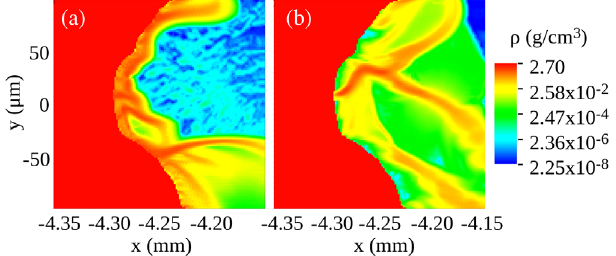
FIG. 8. FLASH 2D-density simulation of a 48-bunch, 200-mA beam dump in aluminum spread over five turns. The domain is the same shown in Fig. 7. The results are shown at (a) 1 . 28 μ s [0.35 turn] and (b) 4 . 37 μ s [1.19